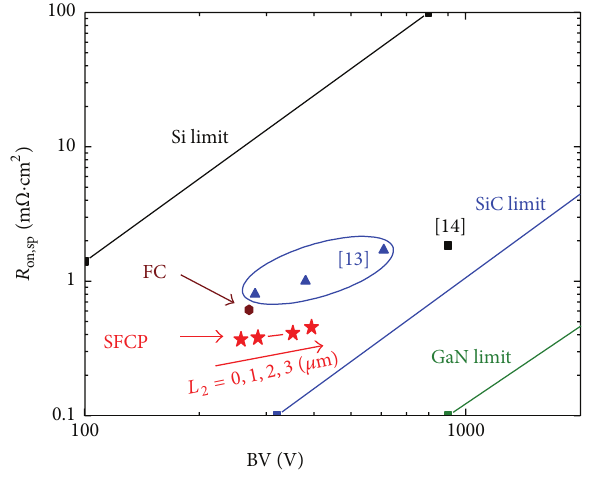
Figure 7: 𝑅 and off-state BV values in the SFCP-MIS-HEMT on , sp and recently reported normally off AlGaN/GaN HEMTs [13,